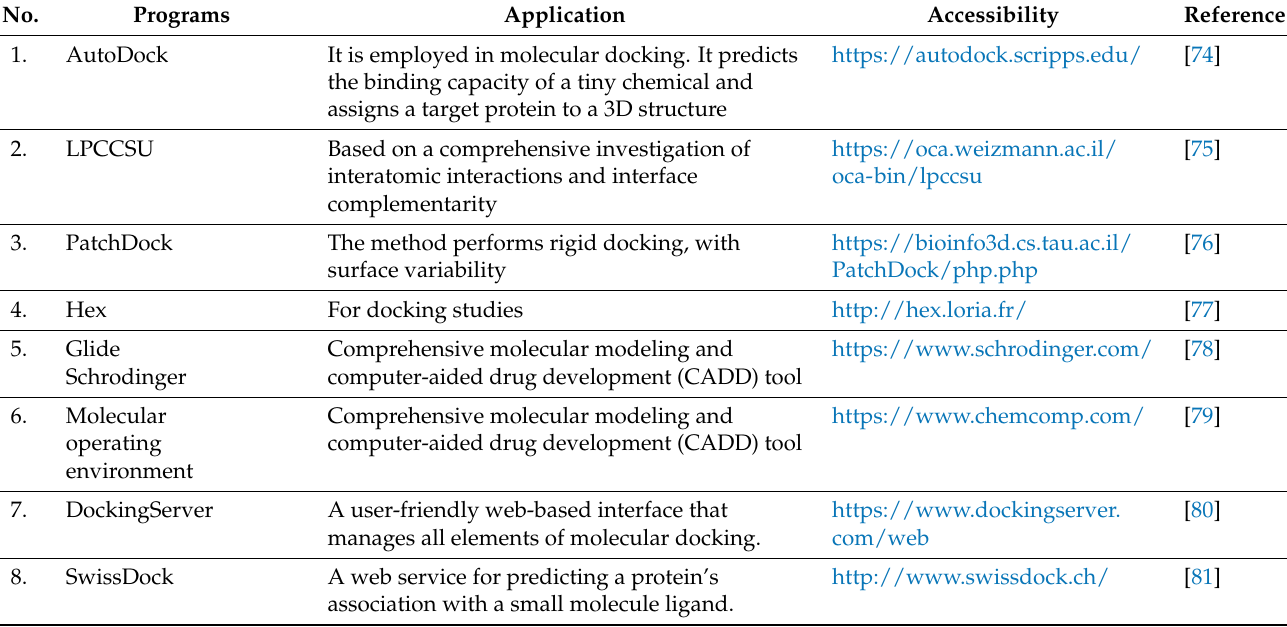
Table 2. Summary of the most widely recognized molecular docking software used across the computational drug design